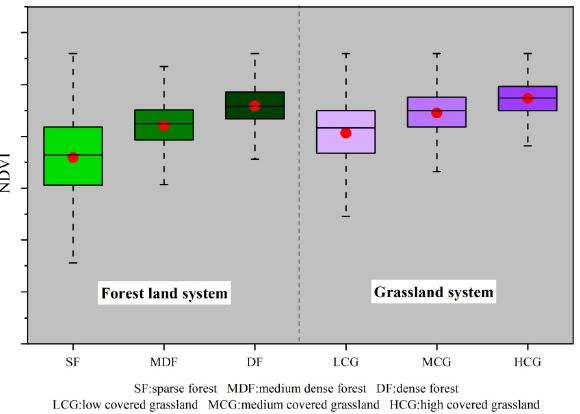
Figure 9. Validation of the results of classification of the forest land and grassland systems. The red point represents the mean NDVI, and the five horizontal lines from top to bottom represent the upper limit, upper quartile, middle value, lower quartile, and lower limit of the NDVI.